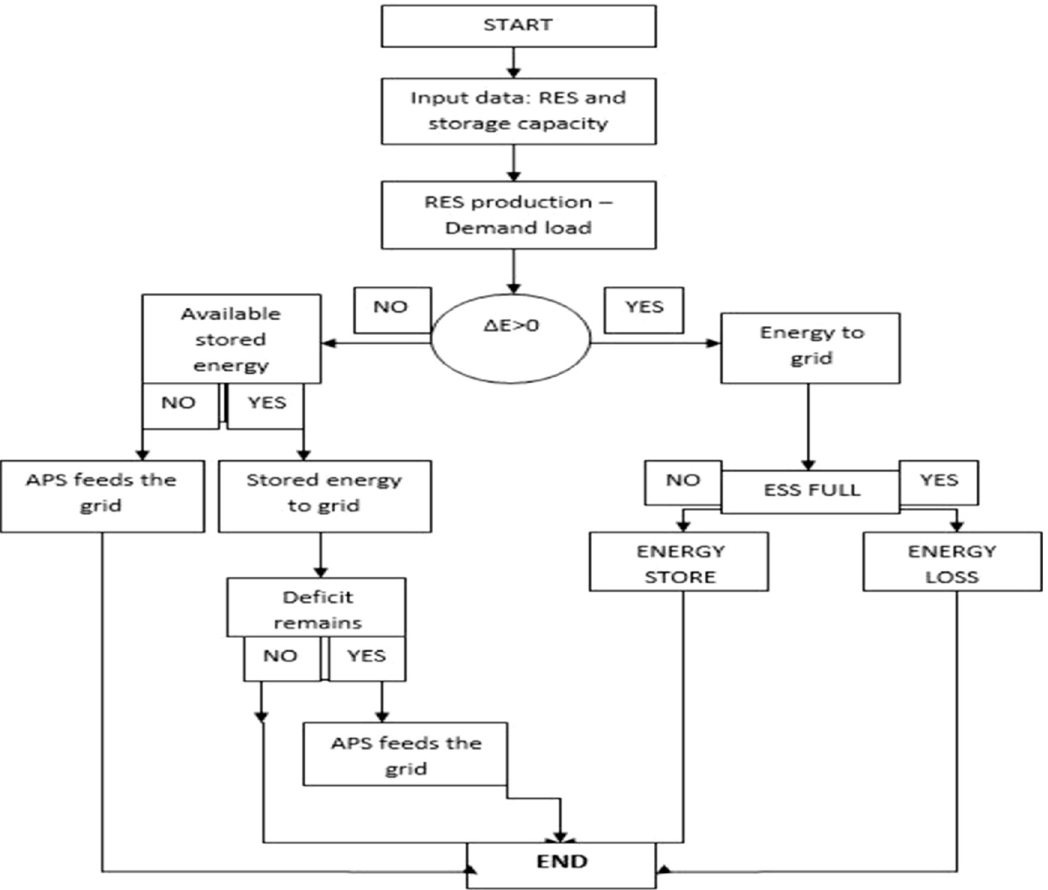
Fig. 9. Energy fl ow